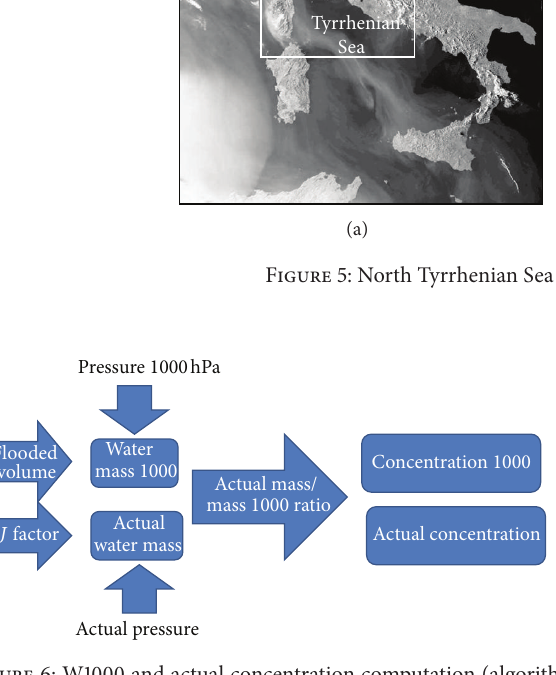
Figure 6: W1000 and actual concentration computation (algorith- mic scheme).